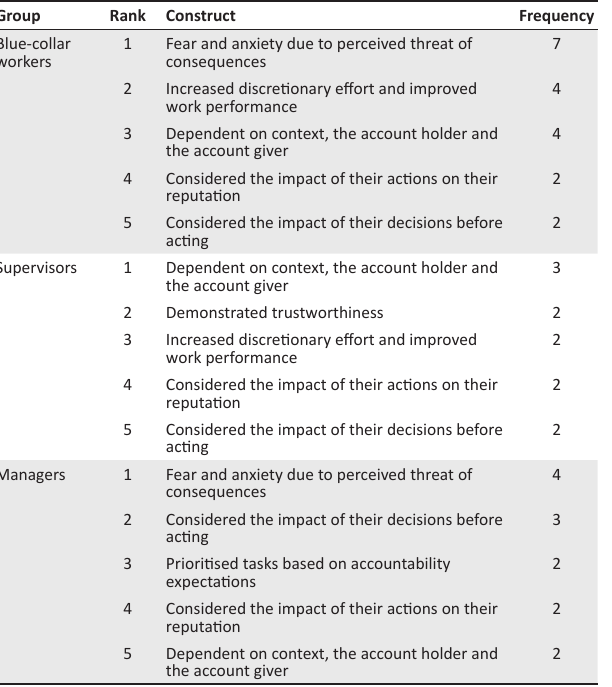
TABLE 4: Influence of accountability on behaviour. Group Rank